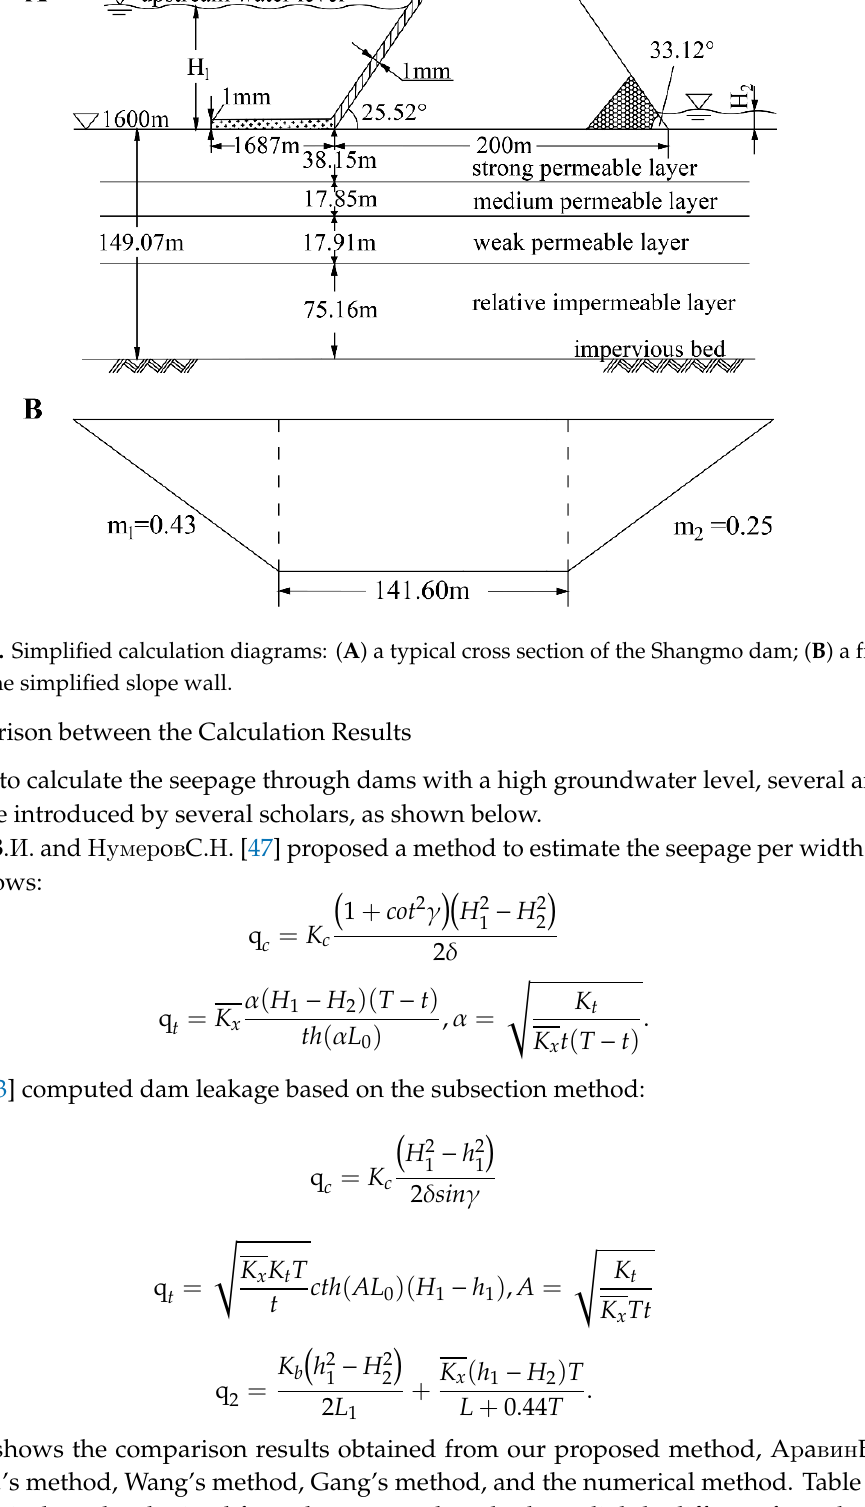
Figure 9. Potential distributions of the seepage field at a typical cross-section of the dam body: ( a ) in normal water level conditions; ( b ) in the designed flood level conditions. 3.2.2. Proposed Calculation Method The values of the variables needed according to the engineering design information are provided in Figure 10. We can conclude that: